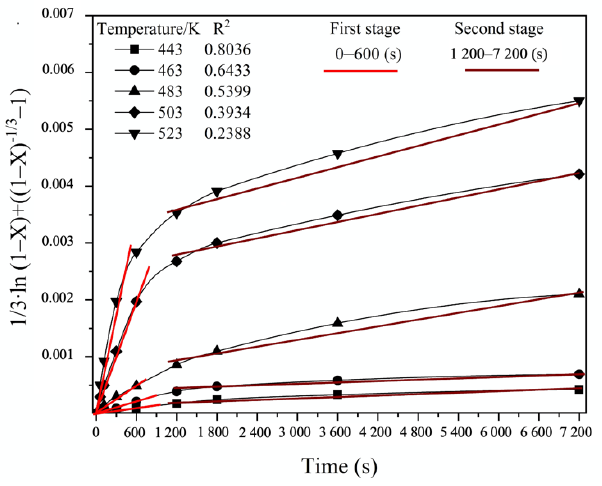
Figure 14. Defined stages on the plot of linear relationship between 1/3·ln (1 - X) + ((1 - X) -1/3 - 1) and hydrothermal treatment time.